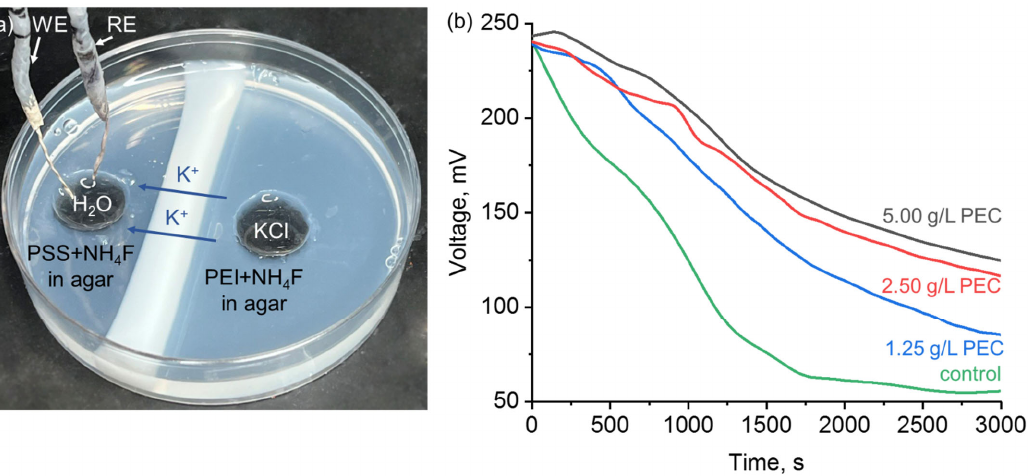
Figure 5. ( a ) Photograph of the electrochemical setup demonstrating K + ion permeability of the PEC membrane (WE = working electrode, RE = reference electrode) and ( b ) chronopotentiograms recorded from K + ‐ selective electrode and corresponding to different concentrations of PEC.